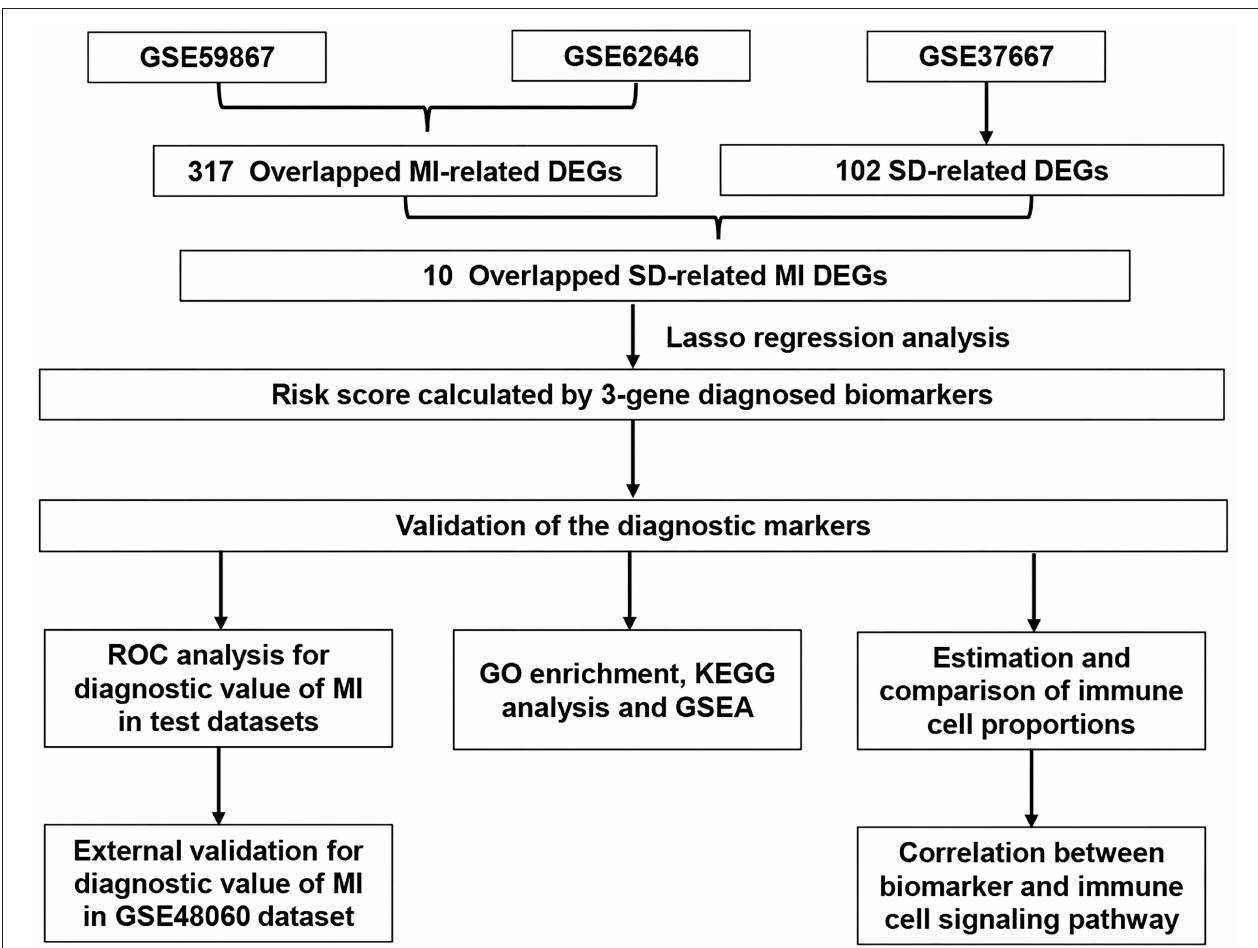
FIGURE 1 | Flowchart describing the process used to identify and validate the diagnostic biomarkers of myocardial infarction. DEGs, differentially expressed genes; MI, myocardial infarction; SD, sleep deprivation; ROC, receiver operating characteristic.